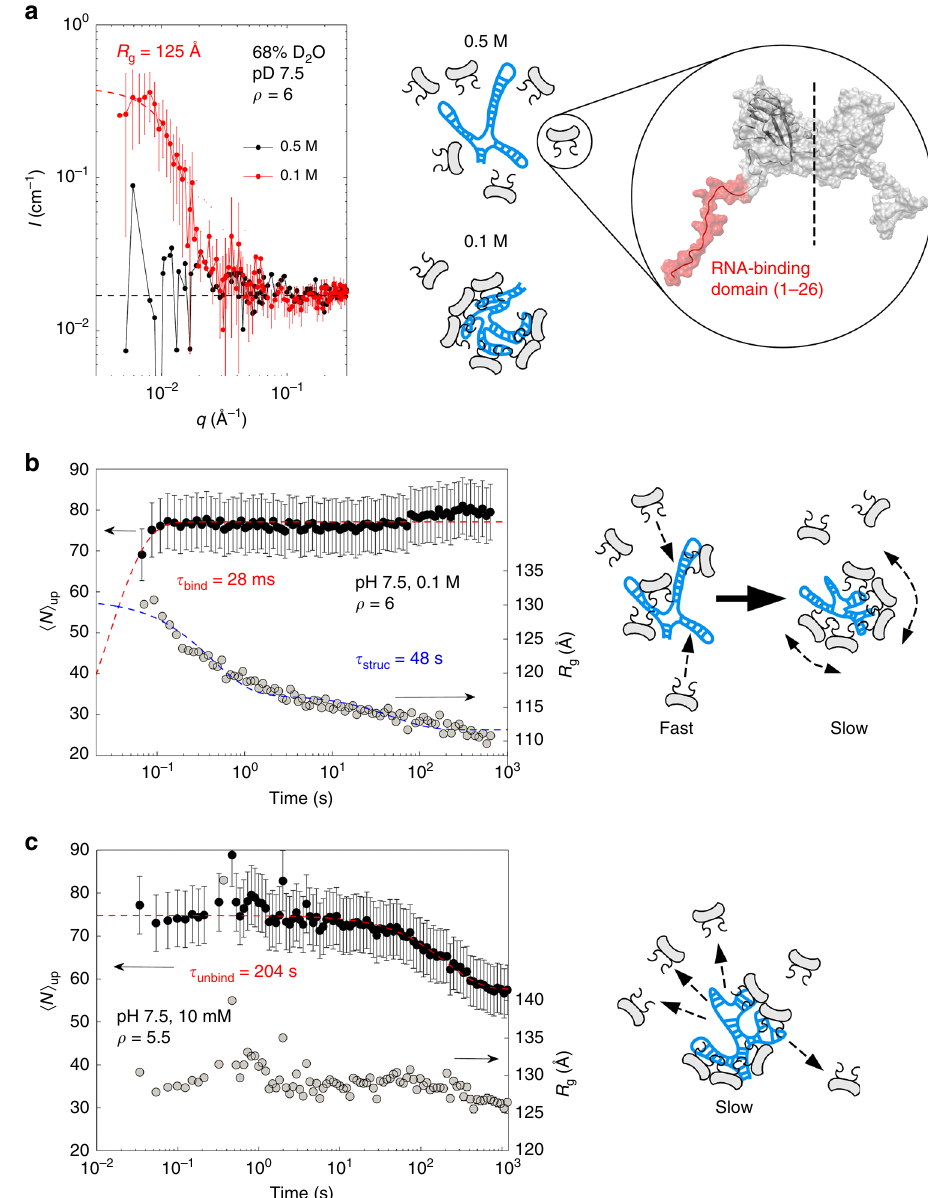
Fig. 1 Self-assembly dynamics of NPCs. a SANS patterns of CCMV subunits and genome in 68% D 2 O at pD 7.5 and for ionic strengths of 0.5 M (black symbols) and 0.1 M (red symbols). The red dashed line is a Guinier approximation and the black dashed line indicates the noise level. The subunit-to- genome mass ratio ρ was 6. The drawing depicts the subunits (in light gray) and the genome (in blue) at the two ionic strengths. (inset) Structure of a CCMV dimeric subunit. The fl exible RNA-binding domain in red contains 26 residues, 10 of which carry one cationic charge 44 . b N h i (black discs) and up radius of gyration R g (light gray discs) as a function of time after mixing subunits and genome at an ionic strength of 0.1 M for ρ = 6. The red and blue dashed lines are single and double exponential decay functions yielding the binding time τ bind and the structural relaxation time τ struc , respectively. The red dashed line starts from the origin since, in this experiment, N h i ( t = 0) = 0. The drawing illustrates the en masse pathway of NPC assembly. c N h i (black up up discs) and R g (light gray discs) as a function of time after a twofold dilution of NPCs pre-assembled at an ionic strength of 10 mM and ρ = 5.5. The red dashed line is a single exponential decay function giving the unbinding time τ unbind . The drawing depicts the release of subunits upon dilution. Error bars are all de fi ned as s.e.m. and were obtained by propagating the standard deviations of neutron or photon counts (see